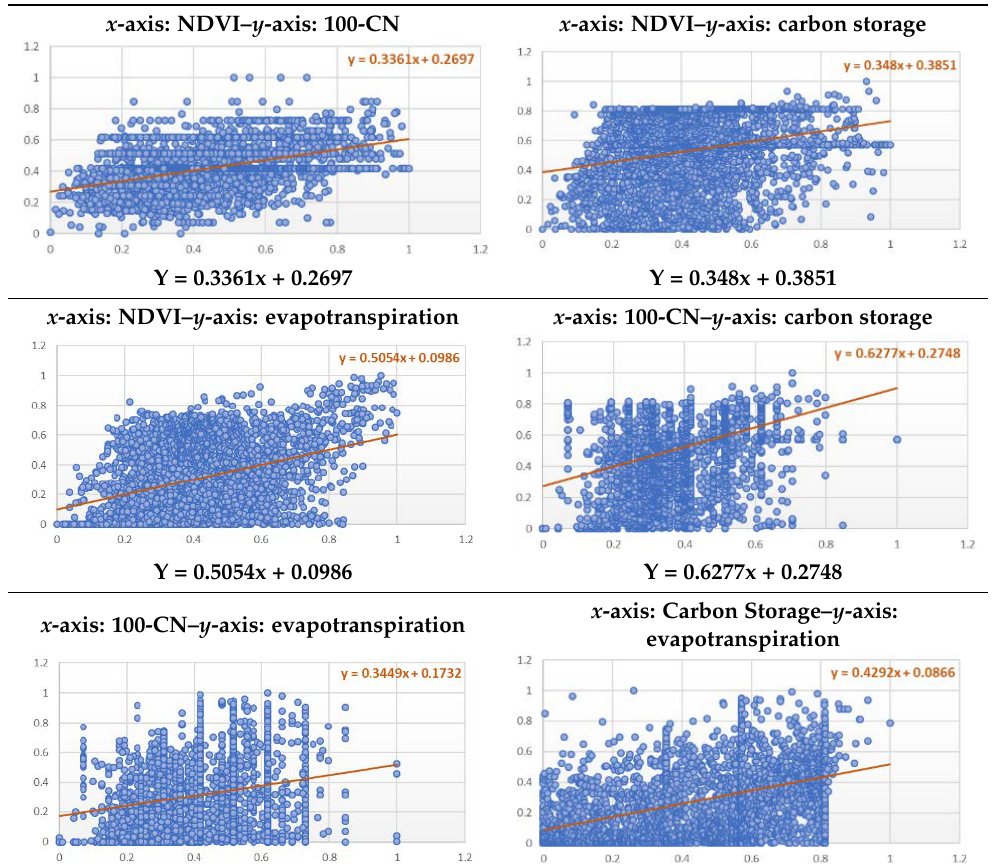
Table A3. Linear regression slopes: type B.